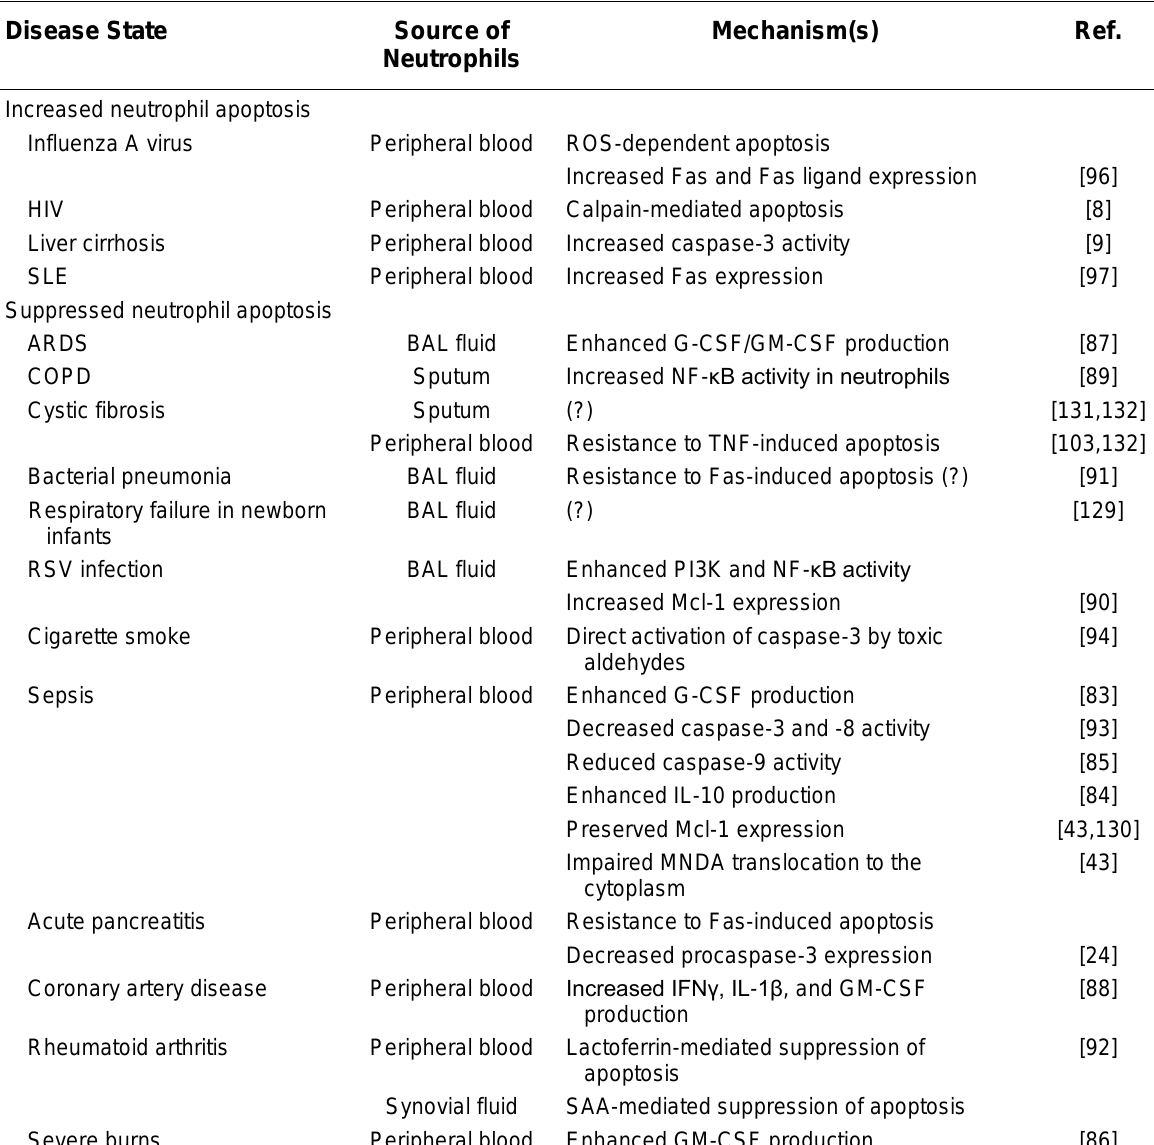
Altered Neutrophil Apoptosis in Human Disease